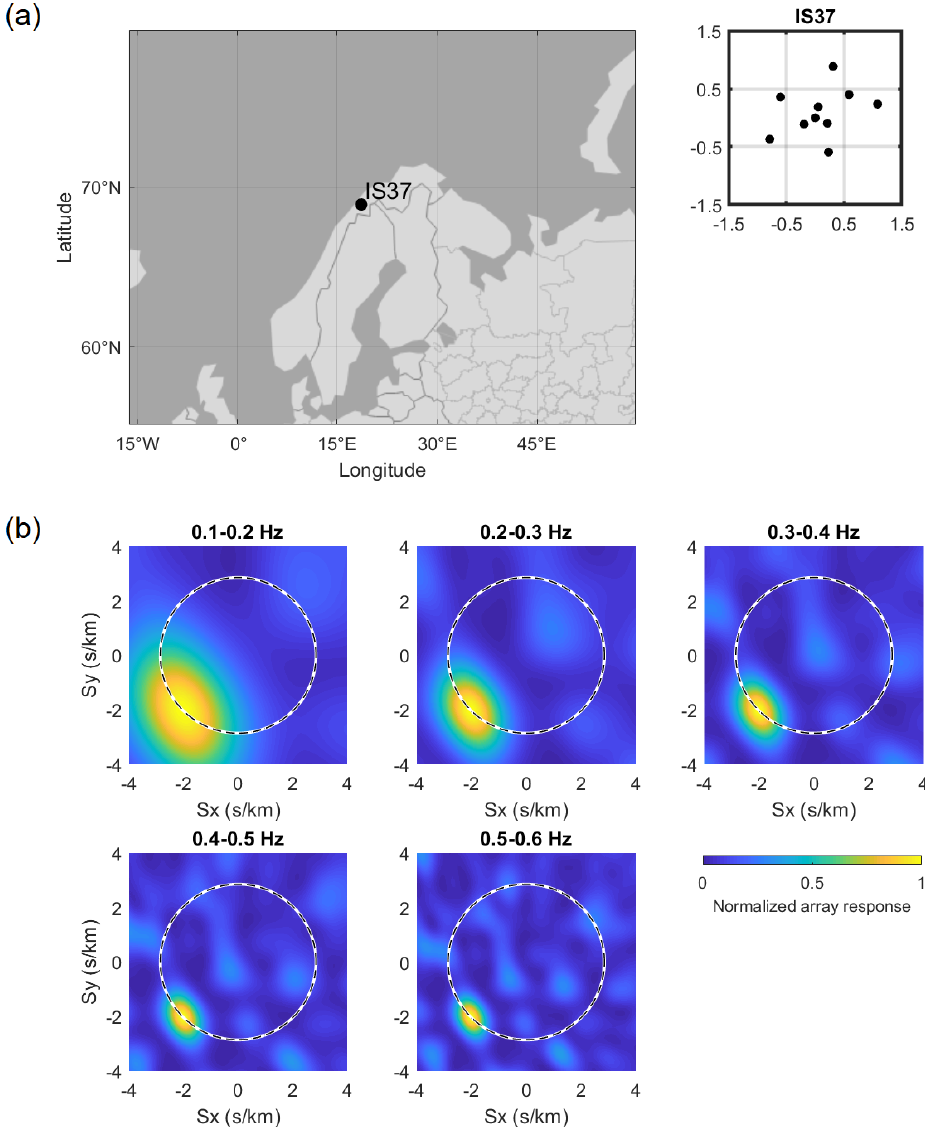
Figure 1. (a) The IS37 infrasound array location and geometry. (b) Integrated steered array response for 0.1Hz wide frequency bands, assuming a plane wave impinging at 225 ◦ back azimuth and 350ms − 1 apparent velocity (indicated with a dashed circle). Here Sx and Sy denote the horizontal components of the slowness